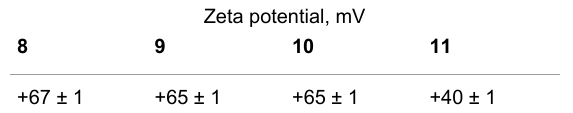
Table 2: The zeta potential of solutions of thiacalix[4]arenes 8 – 11 at a concentration of 1 × 10 − 4 М in water. Zeta potential,